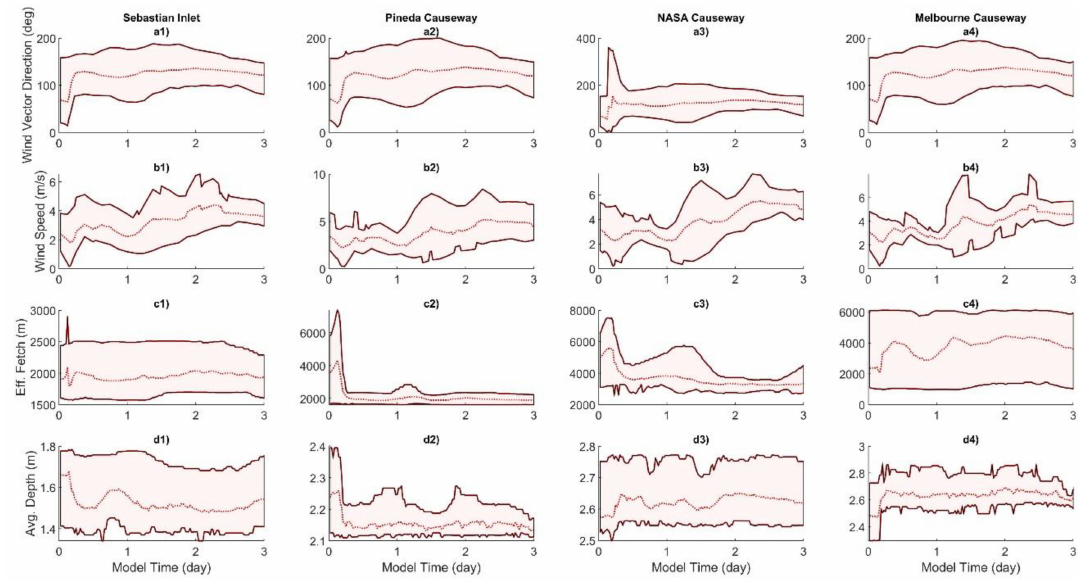
Figure 9. Time series plots of ( a ) ensemble wind directions (degrees), ( b ) ensemble wind speed magnitudes (m/s), ( c ) ensemble effective fetches along wind direction (meters), and ( d ) ensemble depths averaged along upwind fetch lengths (meters); near (1) Sebastian Inlet, (2) Pineda Causeway, (3) NASA Causeway, and (4) Melbourne Causeway. Wind directions indicated the direction wind was travelling towards, with North at 90 degrees. Each of the four locations was selected based on positioning in the domain and associated fetch (station coordinates specified in Figure 8). Dotted lines represent the average value across the full ensemble, while upper and lower bounds of shaded areas represent the maximum and minimum values of the whole ensemble.